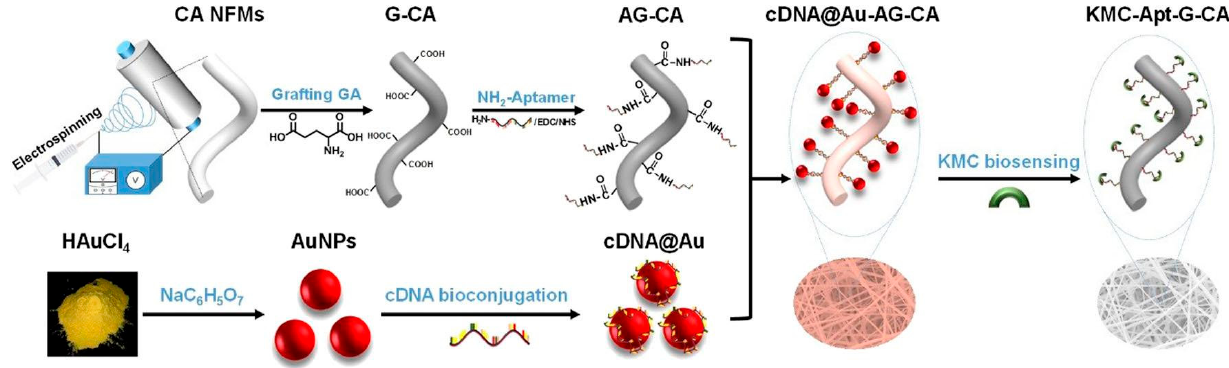
Figure 13. Colorimetric aptasensor for kanamycin detection in water and milk. Portable glutamic acid-grafted cellulose acetate NF membranes functionalized with kanamycin aptamer and hybridized with cDNA-coated AuNPs, the probes, react to detect the analyte, i.e., kanamycin, leading to disassembly of the aptamer–cDNA complex and release of the probes, which can be visualized as bleaching of the strips. Image adapted from [99] with permission of Springer Nature, 2020.